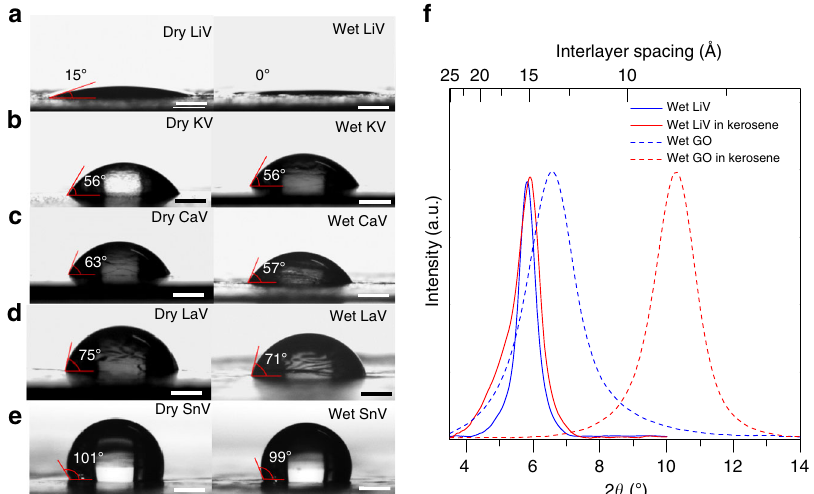
Fig. 2 Wetting properties of vermiculite laminates. a – e Water contact angle of lithium vermiculite (LiV), potassium vermiculite (KV), calcium vermiculite (CaV), lanthanum vermiculite (LaV), and tin vermiculite (SnV) -laminates in dry and wet states. Scale bar, 750 μ m. We also measured the water contact angle for sodium vermiculite (NaV) and obtained a similar value (52 ± 1°) to that of KV (Supplementary Fig. 5). f Evaluation of water pinning property of free-standing wet LiV laminate measured by capturing XRD from wet LiV laminate before and after immersing in kerosene for a week. As a reference, a hydrophilic graphene oxide (GO) laminate was also tested in the same experimental conditions, it was found that water molecules were released from the GO membrane after 12 h of kerosene exposure. Source data are provided as a Source Data fi